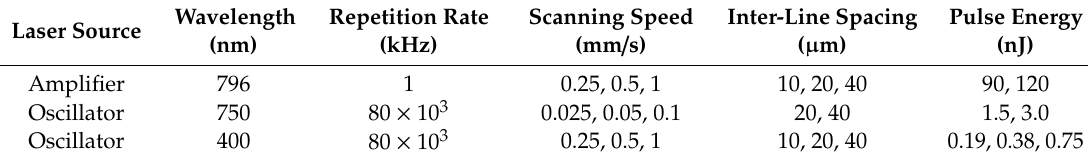
Figure 1. Optical transmission spectra of poly-hydroxyethyl-methacrylate (PHEMA) and PHEMA-UV samples. Arrows point out the laser wavelengths used to process the samples, and the optical transmittance at these wavelengths is also indicated. Table 1. Processing parameters utilized to fabricate the di ff raction